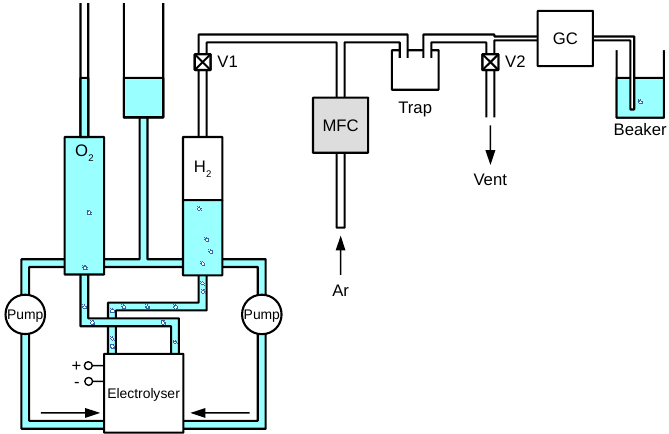
Figure 5. Experimental set-up for electrolyser